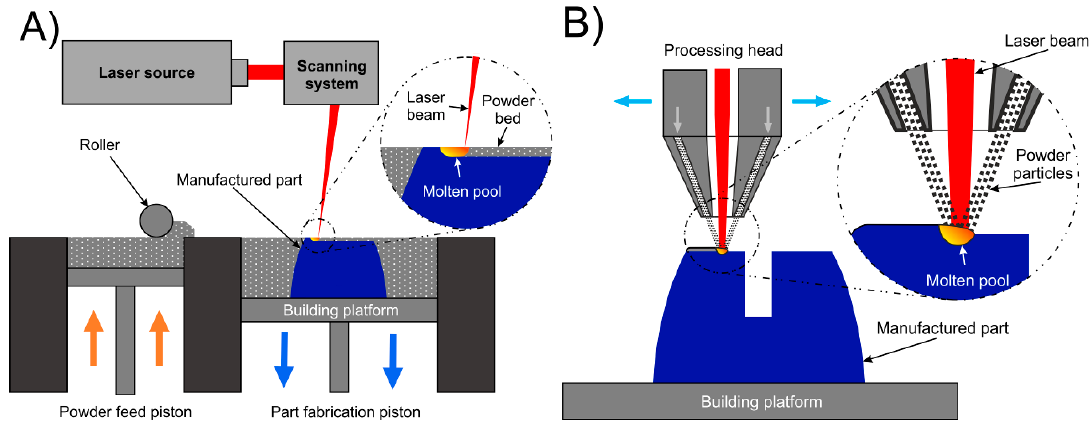
Figure 1. Outline of the selective laser melting (SLM) ( A ) and the directed laser deposition (LDED) ( B ) manufacturing techniques.